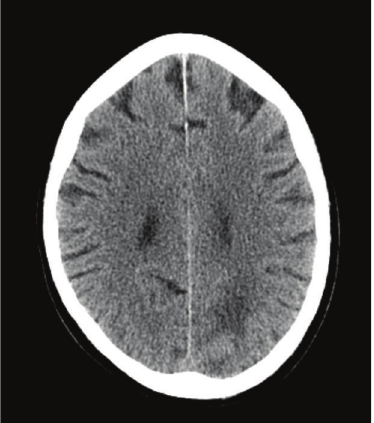
Figure 9: Head CT scan showing multiple brain metastases left breast tissue (low power